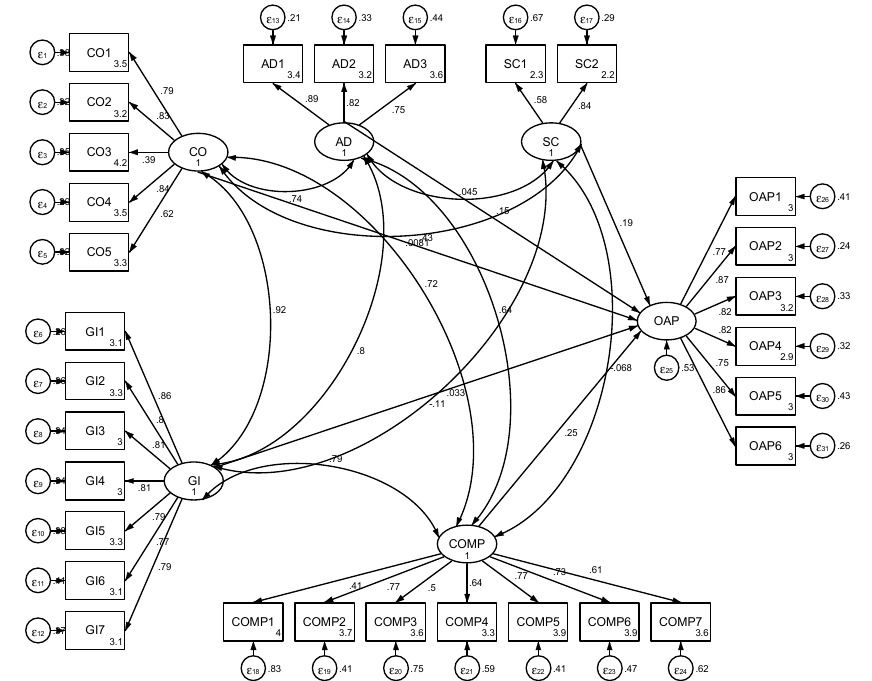
Figure 3. Structural equation model—estimated values.